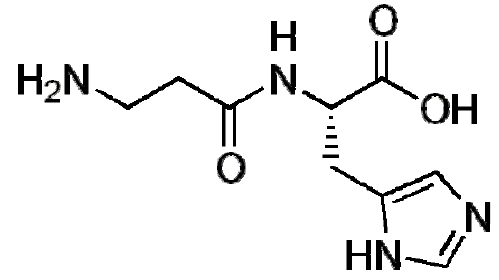
Figure 1. Chemical structure of